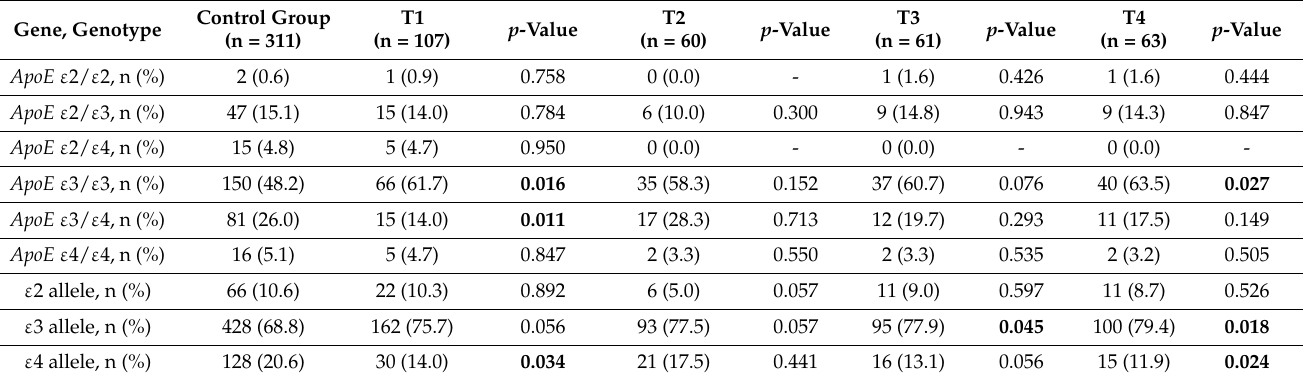
Table 6. Frequencies of ApoE genotypes and alleles in the healthy control group and LSCC patient subgroups regarding tumor